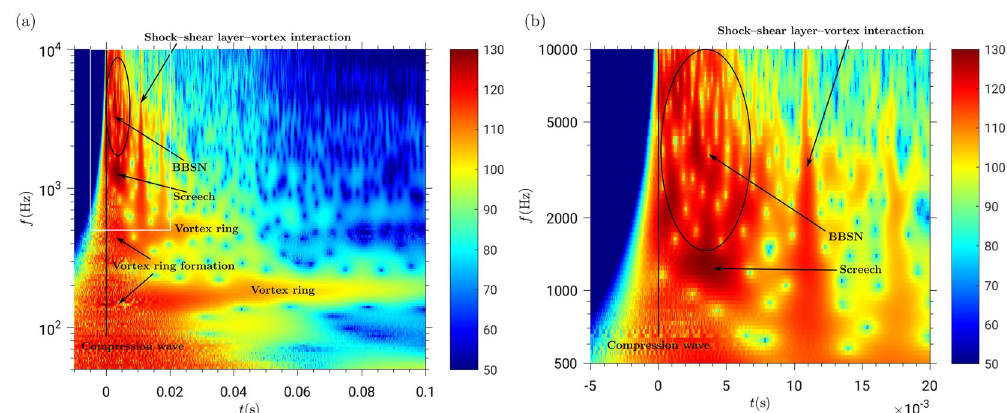
Figure 3. Identification of the elements of the starting jet in the wavelet diagram. The color scale represents the sound pressure level [dB] at the microphone location. Pressure ratio p r /p ∞ = 50; L/D = 8; A e /A * = 1. ( a ) The compression wave, vortex ring, screech, broadband shock noise and the shock-shear layer-vortex interaction can be identified in the diagram by matching the frequency and time delay estimations with the patterns found in the spectrogram from the recorded signals. The white frame is the region represented in panel ( b ). ( b ) Zoom in of the wavelet diagram. BBSN and screech can be identified as well as the shock-shear layer-vortex